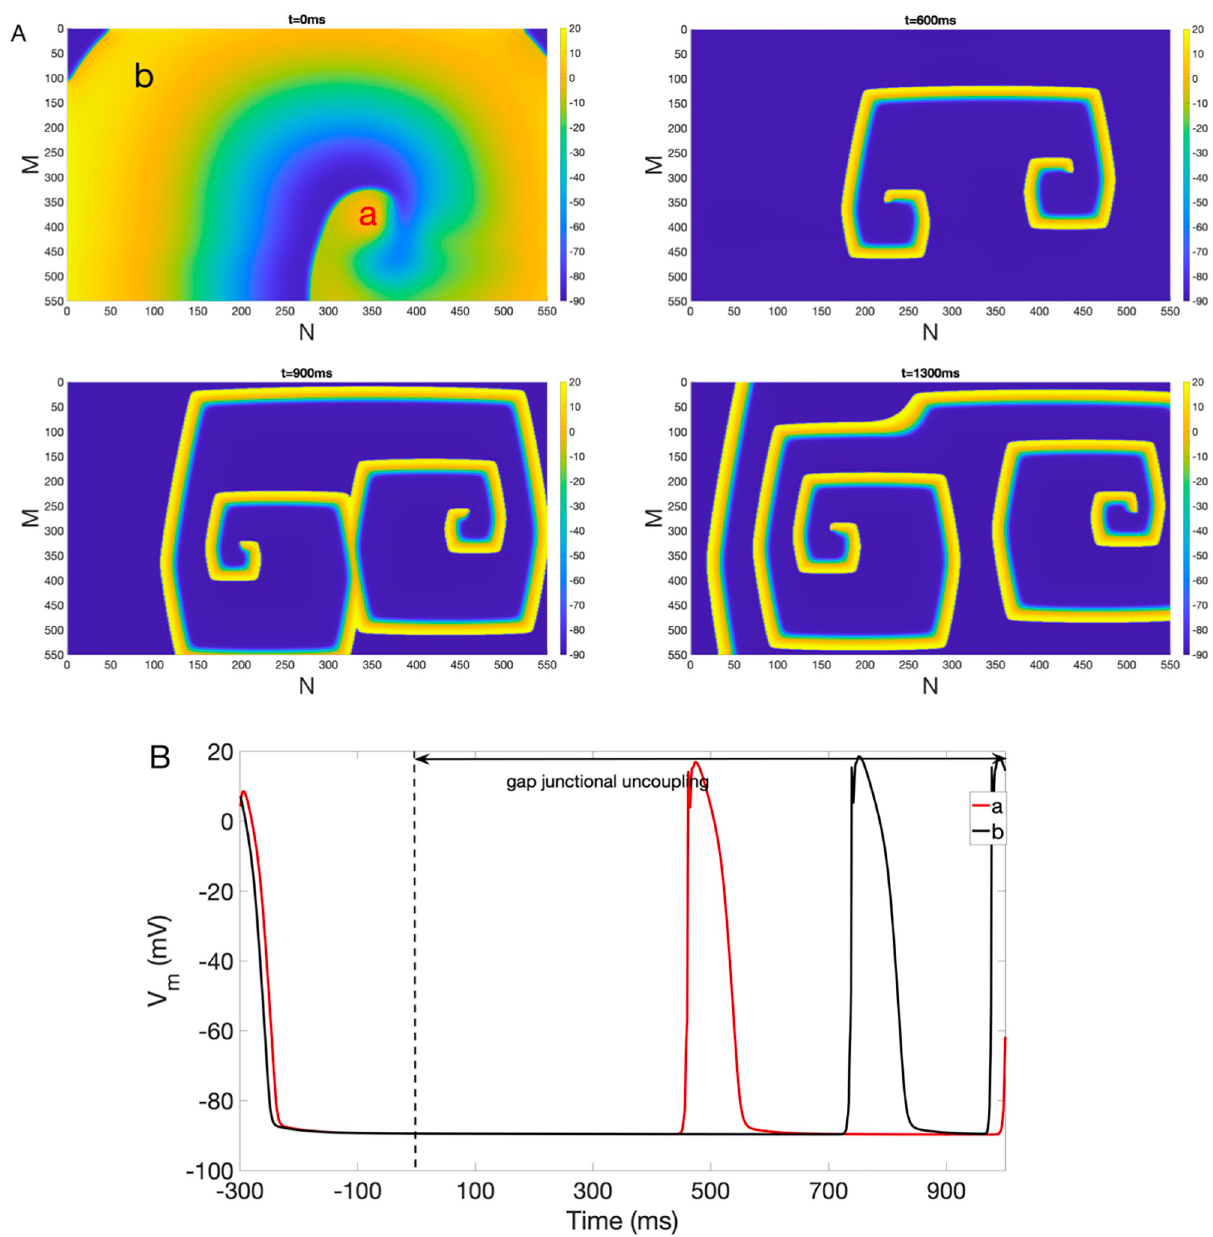
Fig 7. Multiple spiral waves generated under gap junctional uncoupling. (A) Multiple reentry in the presence of gap junctional uncoupling. Colorbar indicates V in the unit of mV. Snapshots of V at time = 0 ms, 600 ms, 900 ms and 1300 ms are shown. (B) Representative V m m and b